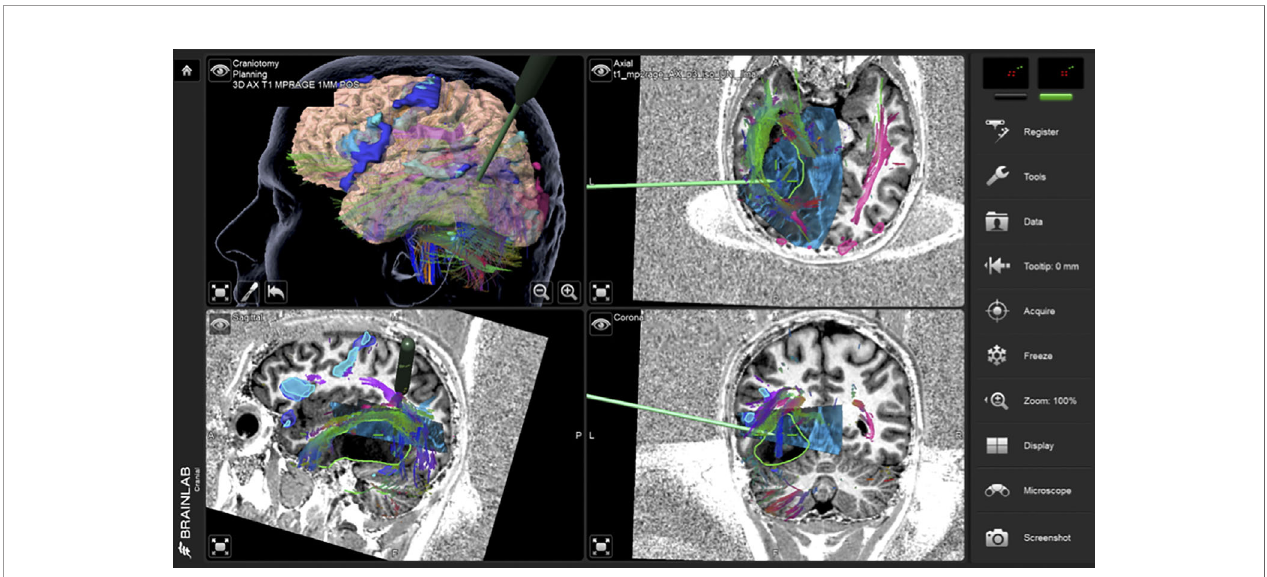
FIGURE 5 | Case 2 intraoperative screen capture with the 3D surgical plan reconstruction with fMRI BOLD activation segmented in dark and light blue and tumor in green (upper left panel), and the three orthogonal planes with 3D iUS-3 overlaid on preoperative MP2Rage. Notice the navigation probe in close proximity to the tracts running through the tumor. In order to preserve these tracts, no further resection medially was